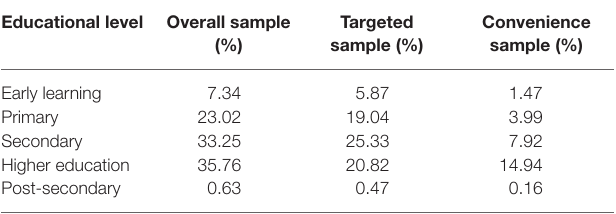
TABLE 5 | Types of student samples studied from 1950 onwards in positive education. Educational level Overall sample (%)